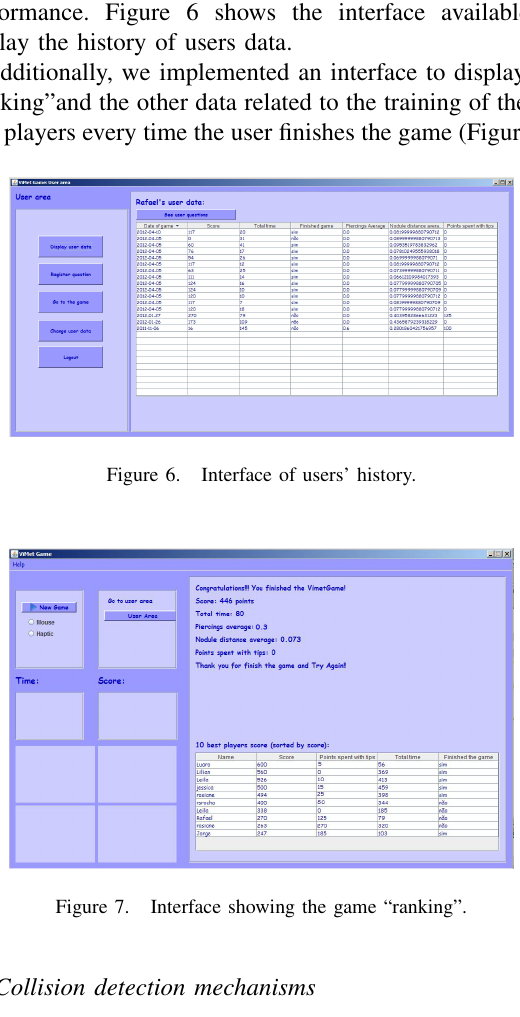
Figure 7. Interface showing the game